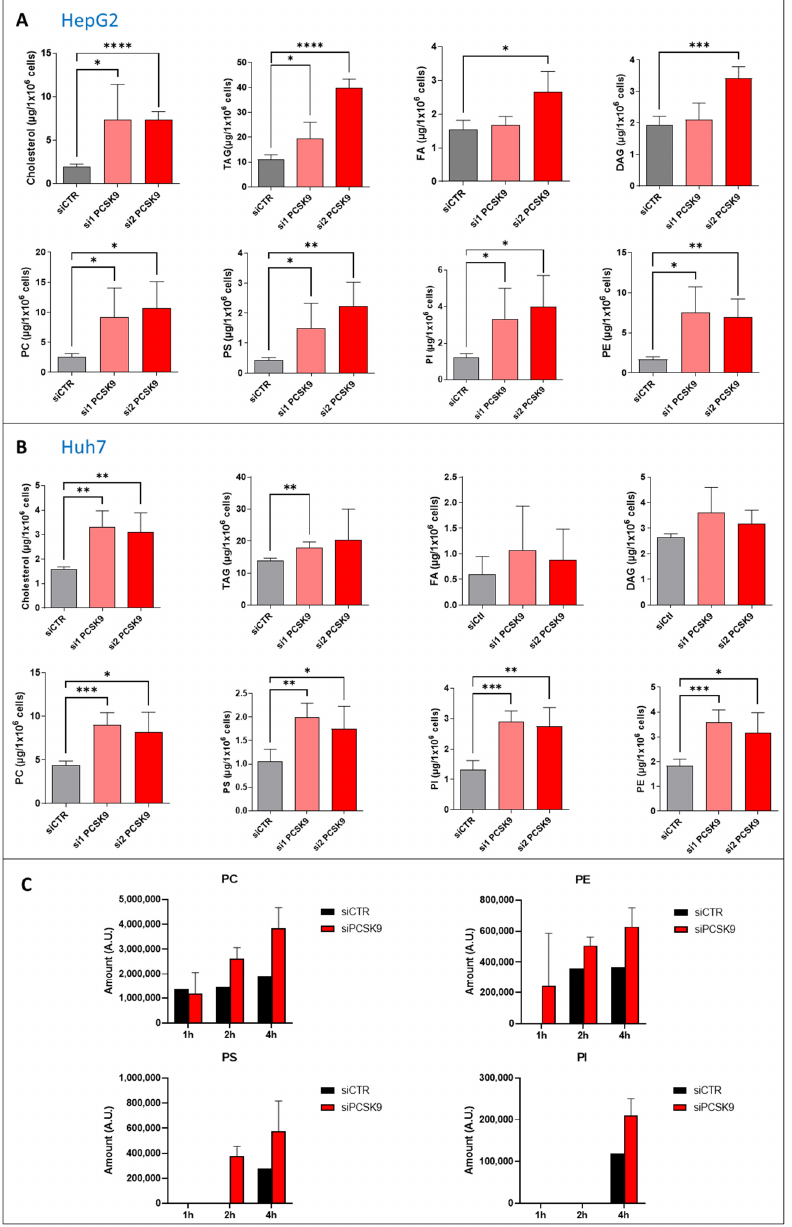
Figure 3. Quantification of neutral lipids and phospholipids after PCSK9 silencing. ( A , B ) Choles- terol, triacyl glycerol (TAG), fatty acid (FA) diacyl glycerol (DAG), phosphatidylcholine (PC),